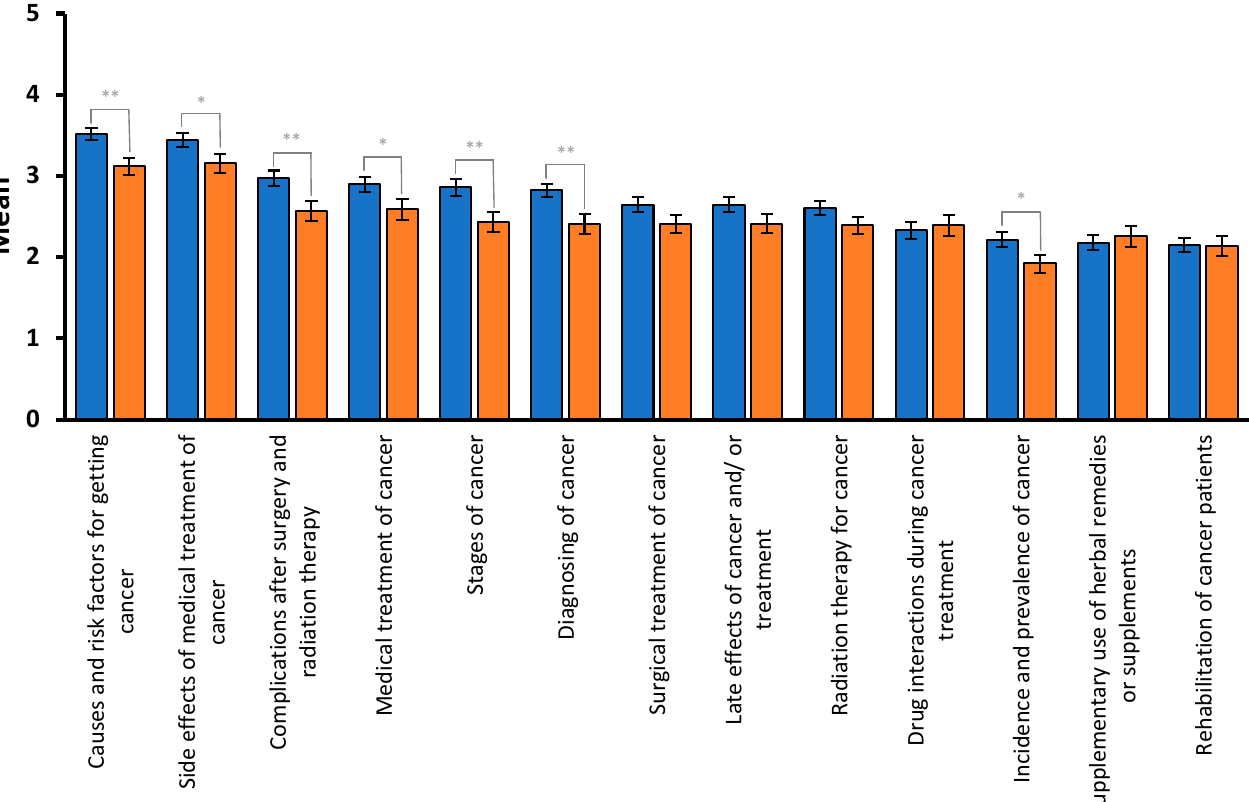
Figure 1. Potential barriers concerning counseling current or former cancer patients at a community pharmacy. Ratings are defined as: Agree and strongly agree. Neutral. Disagree and strongly disagree. (n = 134).